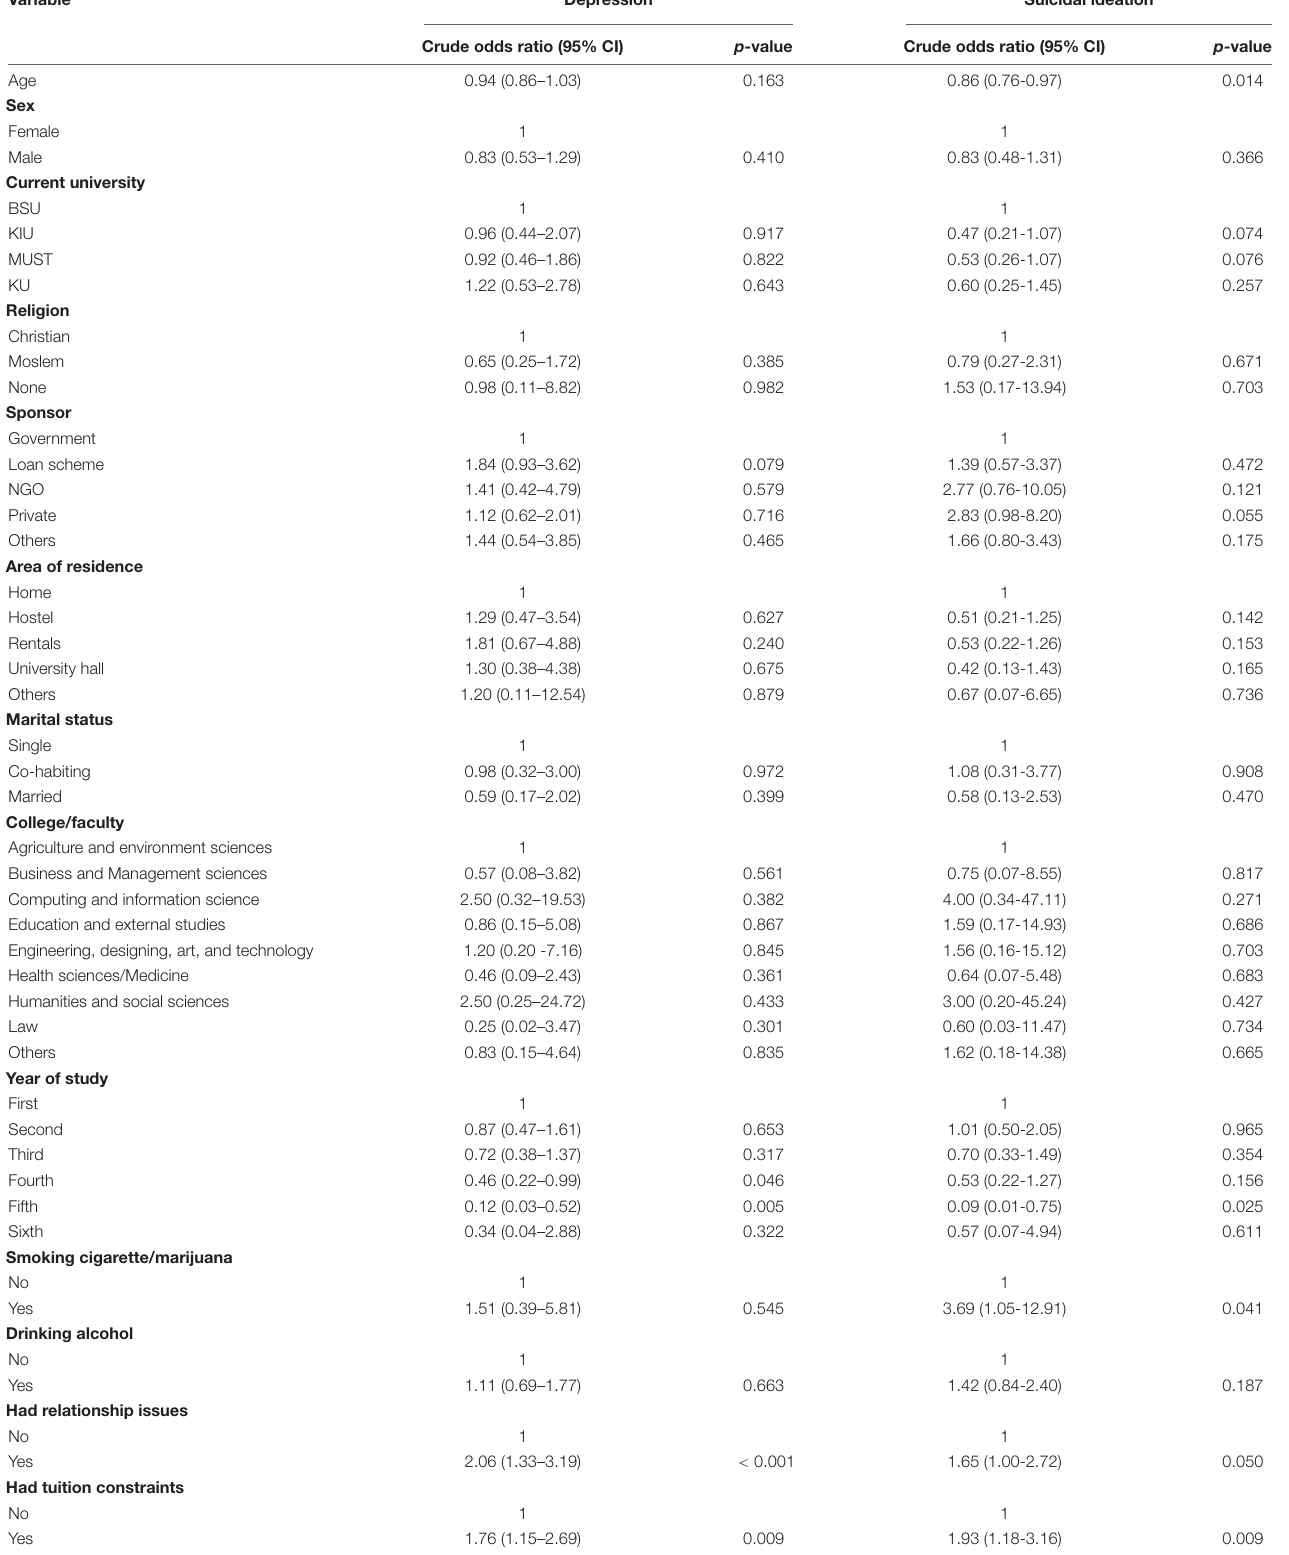
TABLE 2 | Bivariate logistic regression analysis of factors associated with depression and suicidal ideation.